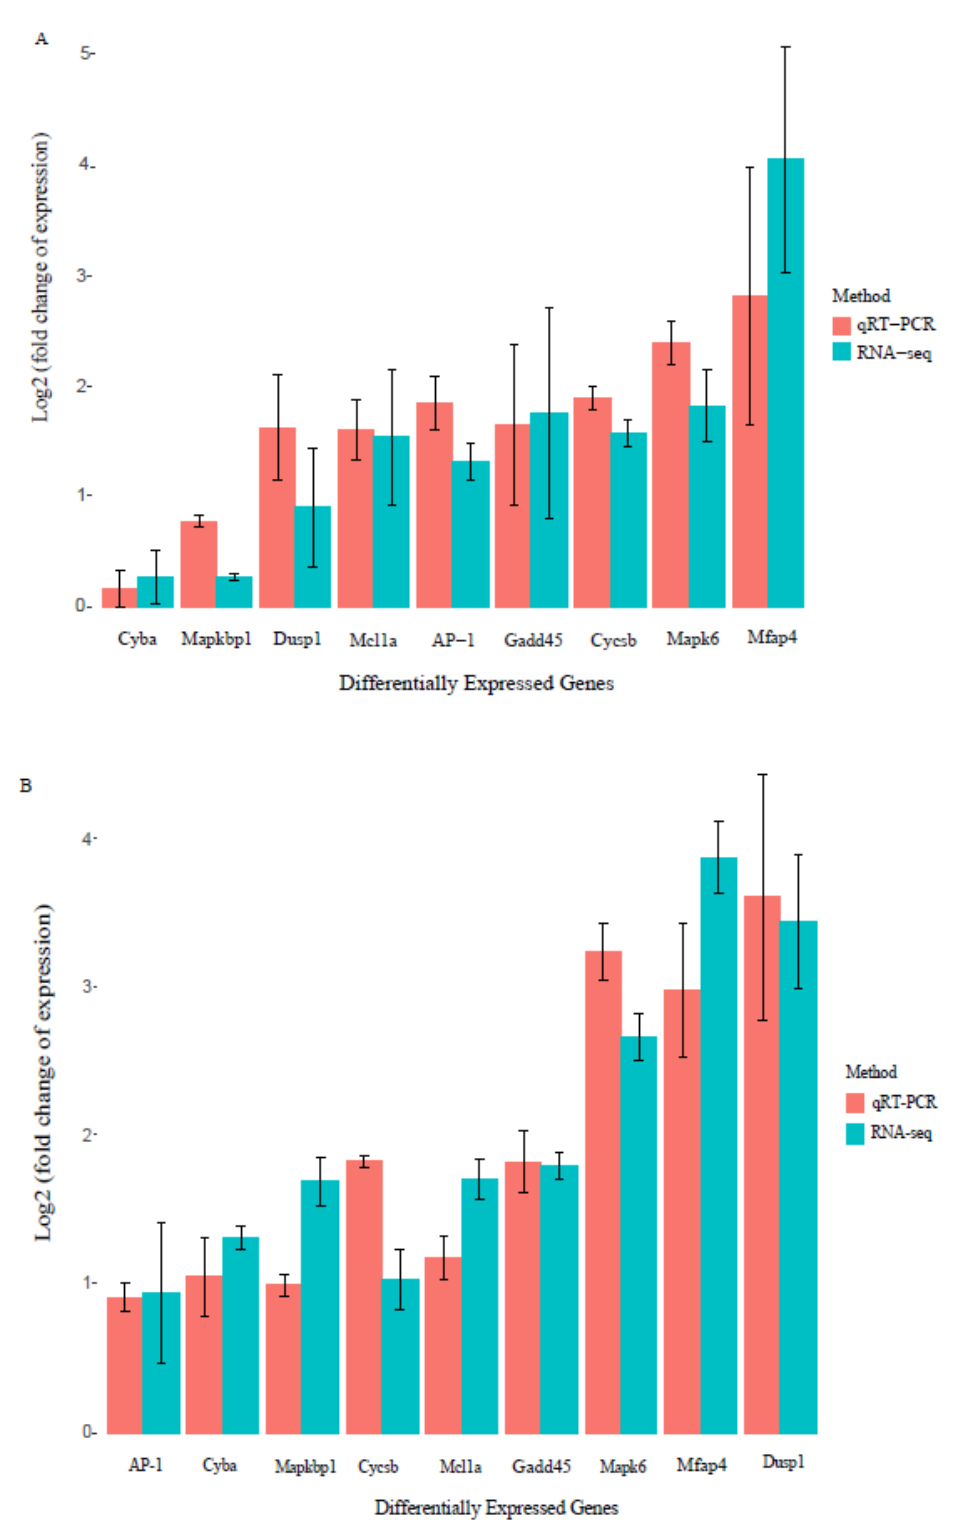
Figure 2. Validation of transcriptome results by quantitative real-time polymerase chain reaction (qRT-PCR). Bars showed the log2-fold change values of nine randomly selected DEGs in two pairwise comparisons: control vs. early-infected stage ( A ) and control vs. late-infected stage ( B ). Red columns represent the transcriptional fold changes measured by qRT-PCR, and green columns indicate the RPKM (reads per kilobase of exon per million fragments mapped) values measured by the transcriptome sequencing. Error bar of each column represents the standard error of the mean from three independent experimental replicates.